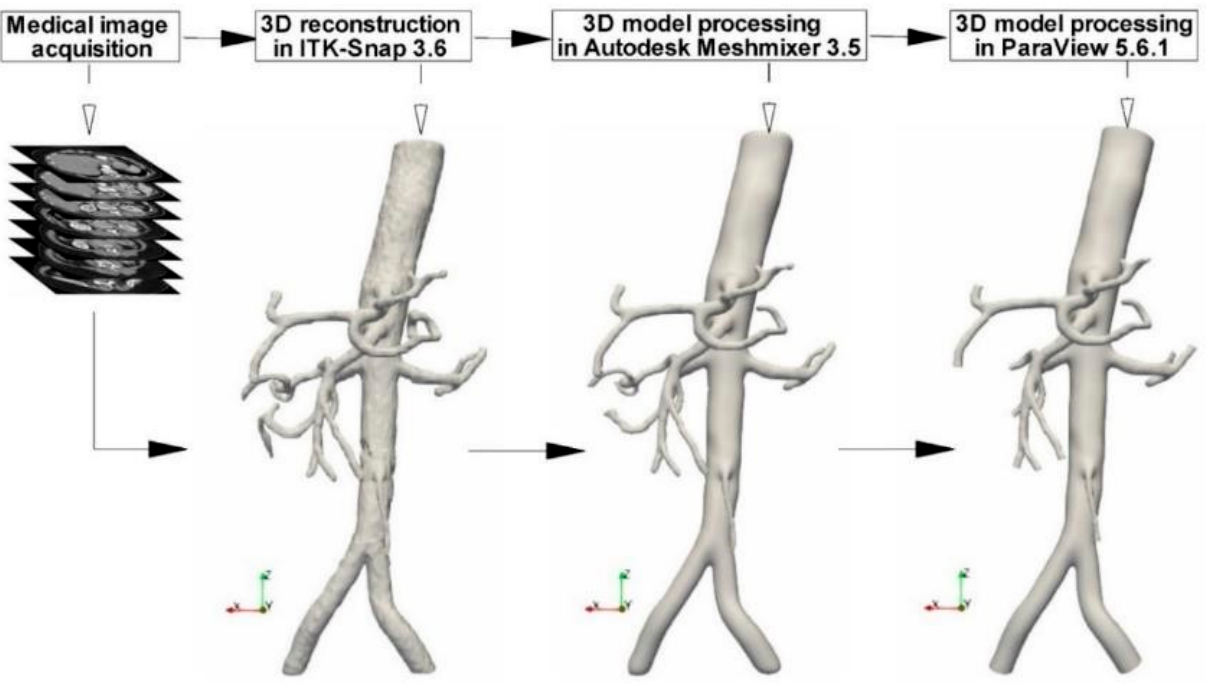
Figure 1. 3D model reconstruction based on the DICOM images acquired during the CTA investi- gation.